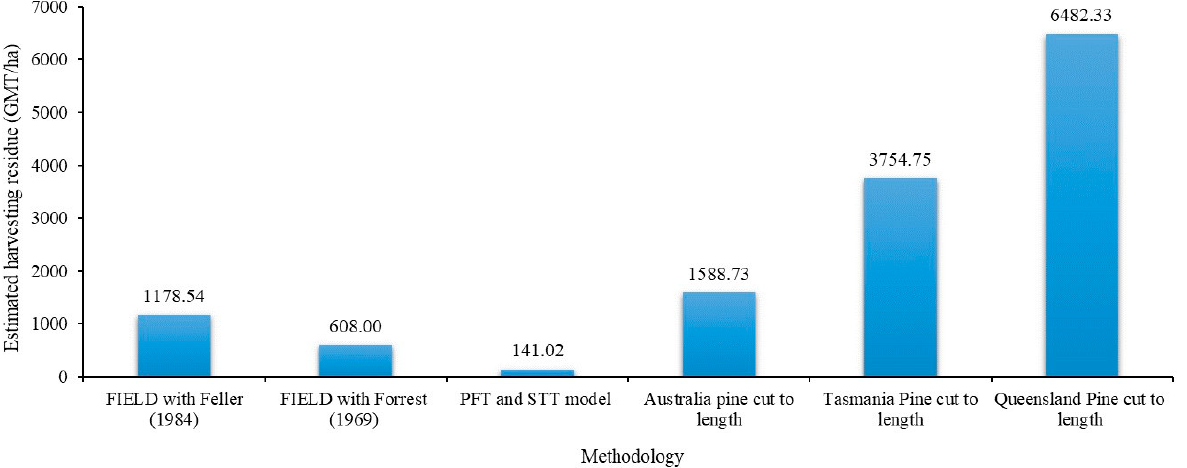
Figure 9. Harvesting residue estimates obtained with different methodological approaches.